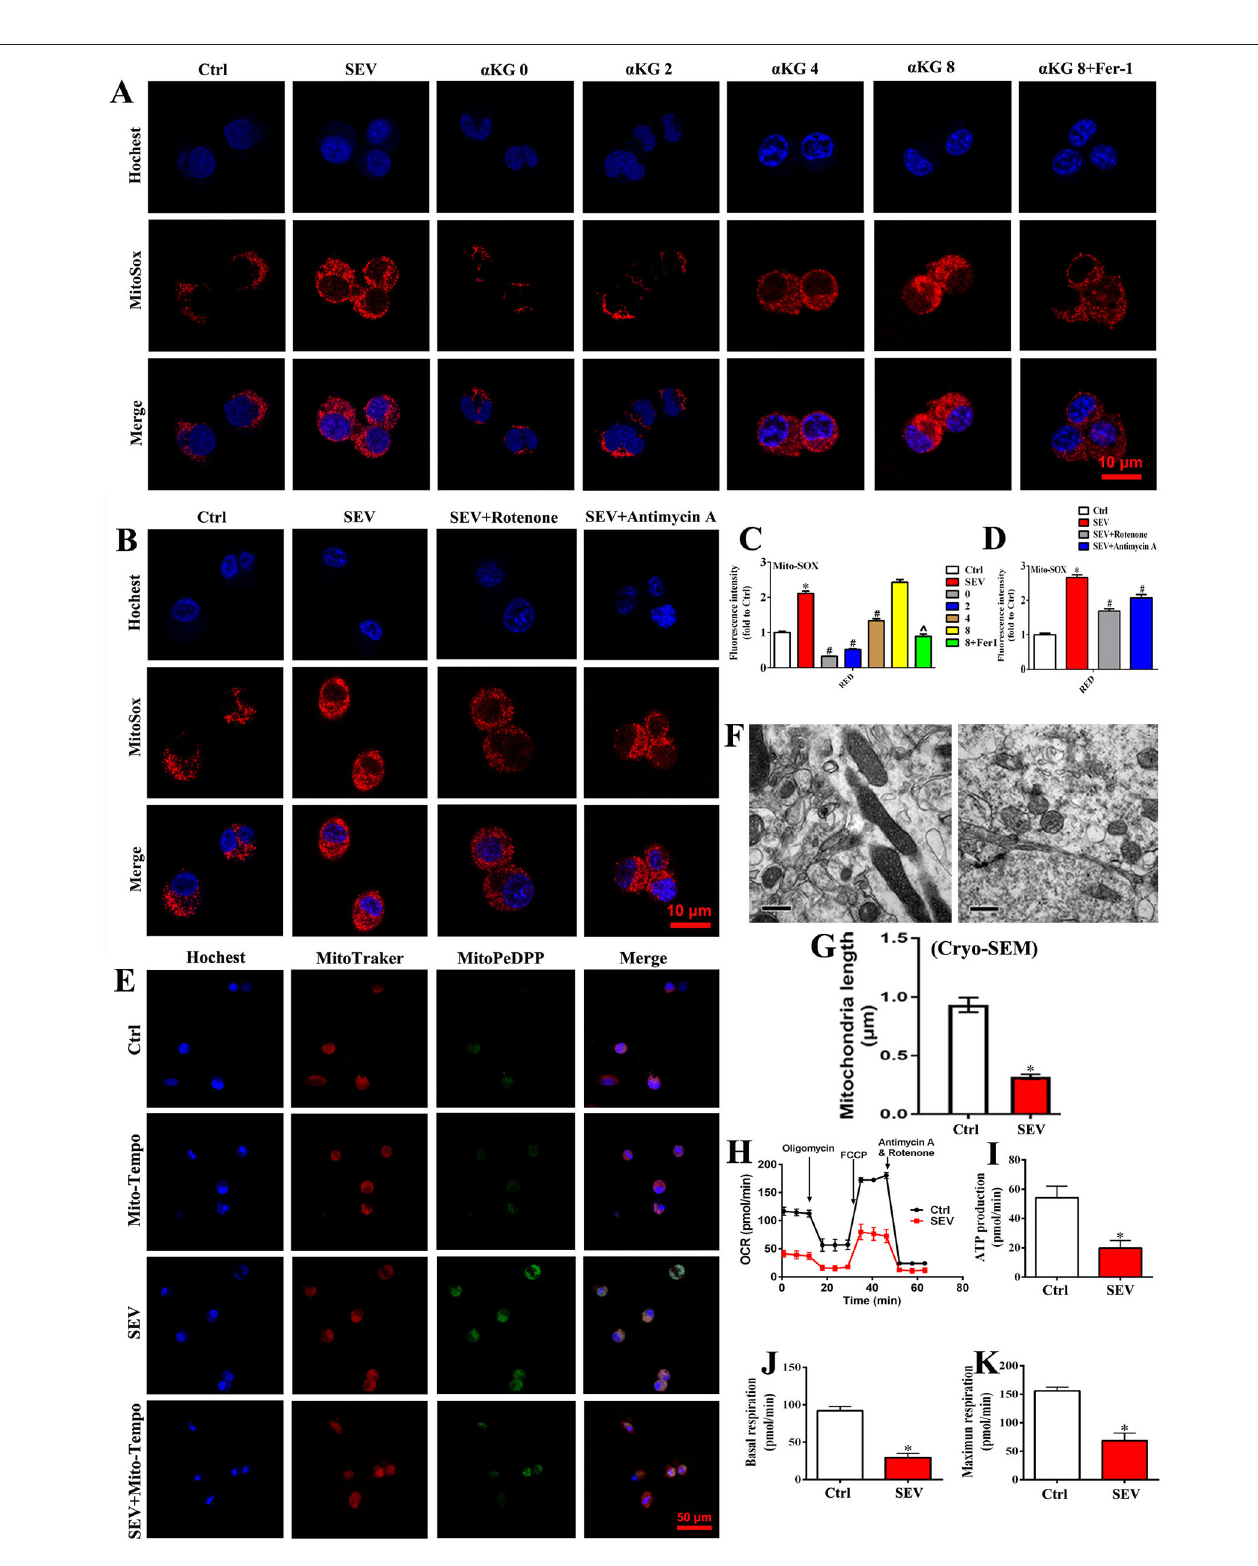
FIGURE 5 | Mitochondrial TCA cycle and ETC were implicated in sevoflurane-induced neurotoxicity. (A,C) MitoSOX staining for investigating the role of mitochondrial TCA cycle in ROS production [one-way ANOVA, Tukey’s multiple comparisons test, Treatment: F (1.601,3.201) = 224.9, mean difference (95% CI): − 1.106 ( −